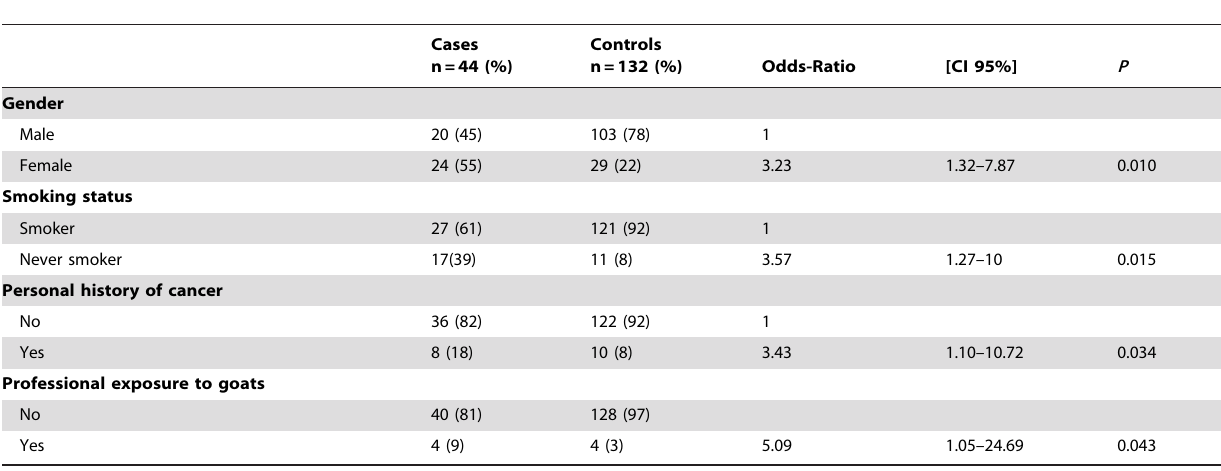
Table 3. Factors independently associated with pneumonic-type lung